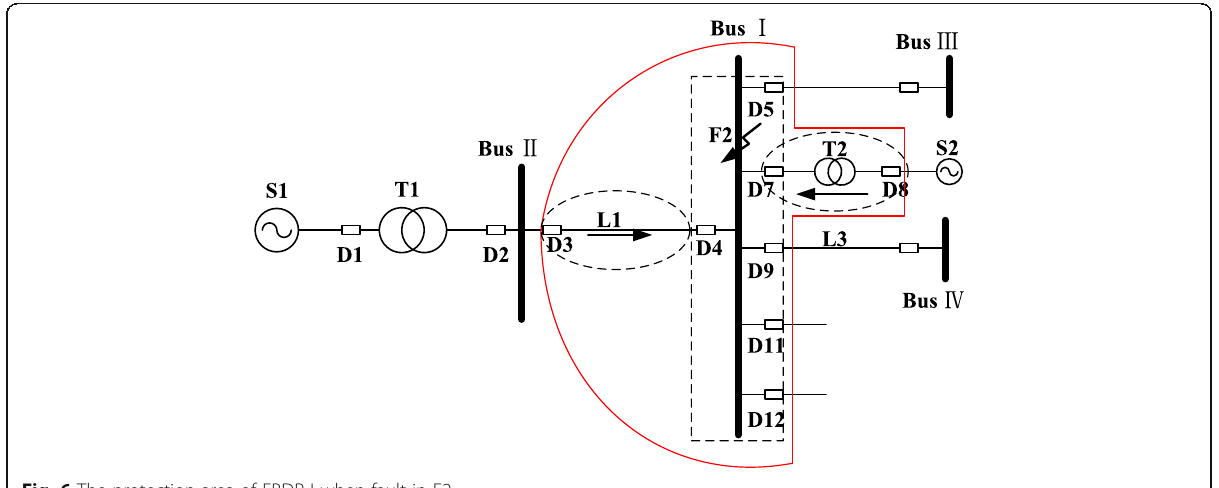
Fig. 6 The protection area of EBDP I when fault in